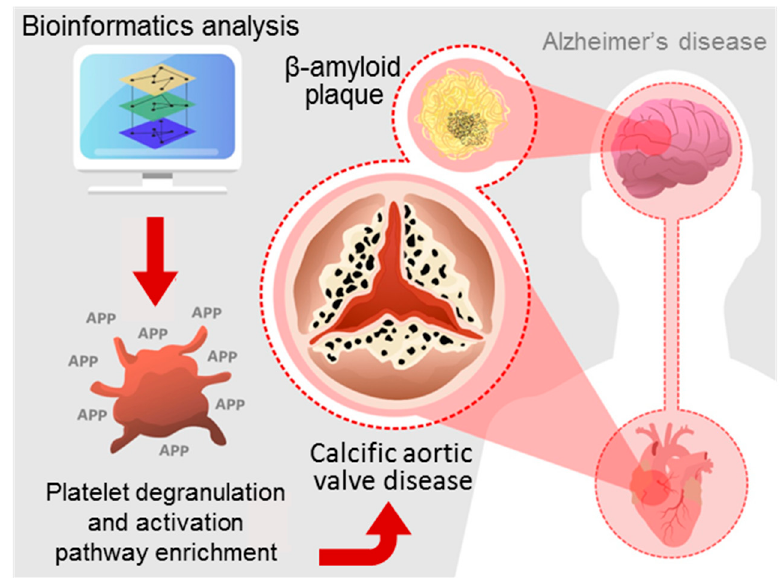
Figure 6. Our study provides a novel molecular CAVD network that is linked to the formation of amyloid-like deposits known from Alzheimer’s disease potentially though the platelet activation/degranulation